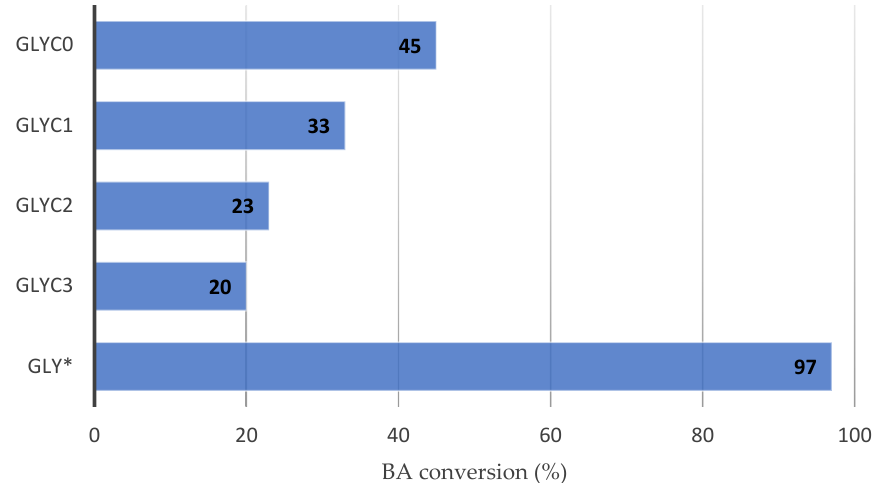
Figure 7. Results of etherification of GlyC with BA. Temperature of 120 °C, ratio Gly: BA = 3:1 and 10 wt.% of catalyst. (GlyC0: 12.36% moisture, GlyC1: 8.17% moisture, GlyC2: 5.78% moisture, GlyC3: 2.36% moisture and Gly* Glycerol refined) [63].